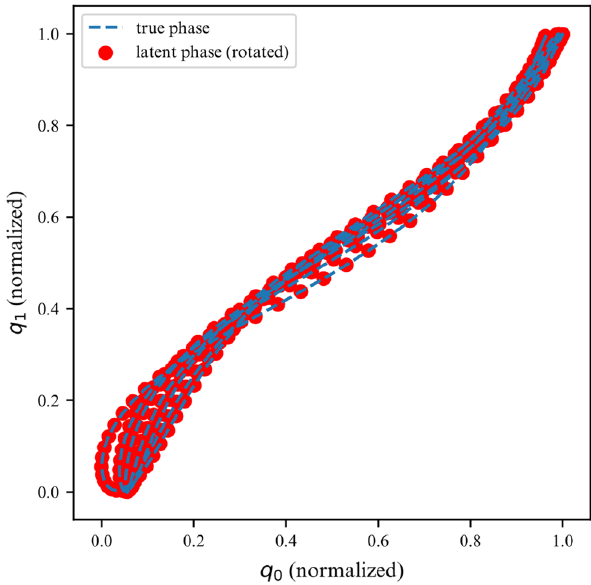
Figure 10. Phase space for the first DOF of a 3DOF system.